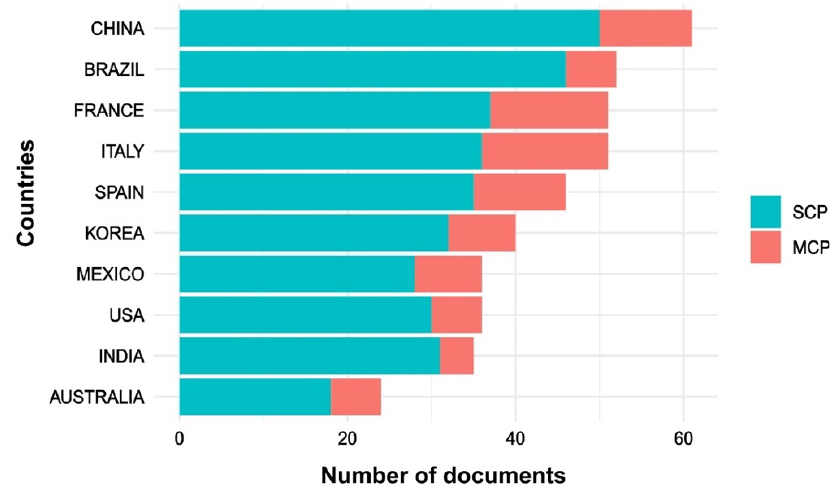
Figure 3. Most productive countries in the field of pigments from microalgae (SCP: single country publications, MCP: multiple country publications).